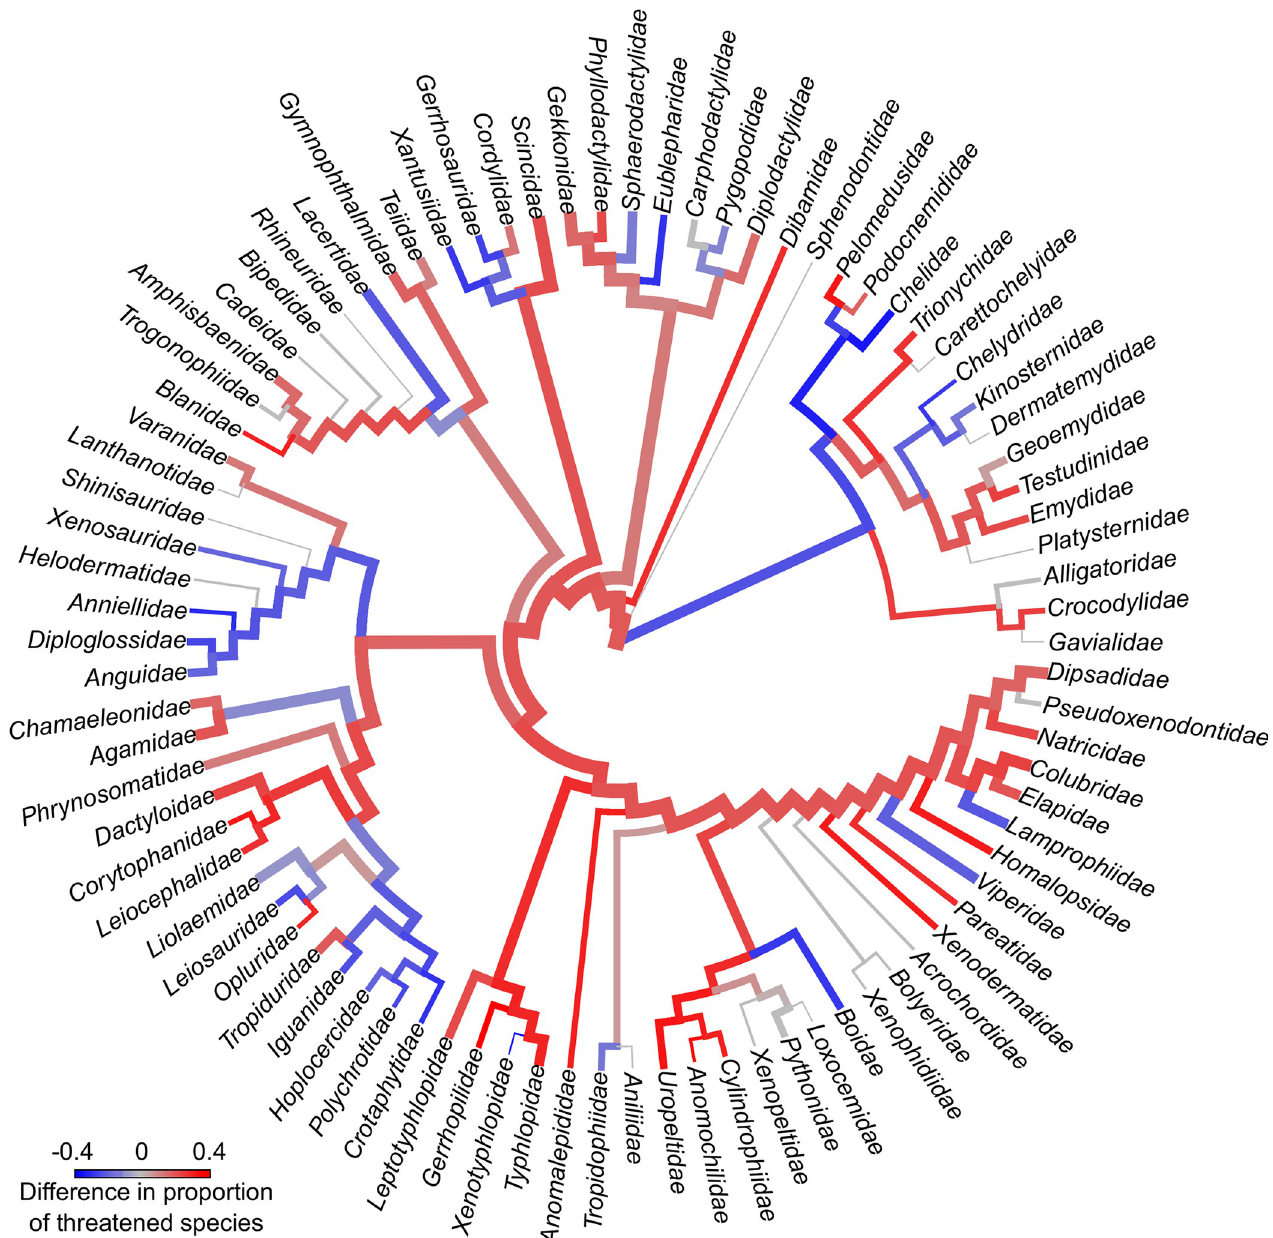
Fig 2. Differences in the percentage of threatened species in reptile families before and after the addition of extinction risk estimates for DD and NE species, obtained from an automated assessment method. Colors in internal nodes represent the difference in percentages for all descendant tips. Trees by Tonini and colleagues [31] (Squamata) and Colston and colleagues [32] (Archelosauria). The shift between red and blue is proportional to the (symmetric log scale) increase/decrease in extinction risk per branch when using our assessments. Branch widths are proportional to log species richness in each clade. Proportion of threatened species for each family, before and after inclusion of automated assessments are detailed in S9 Table. The data underlying this figure can be found in S2 Data. DD, Data Deficient; NE, Not